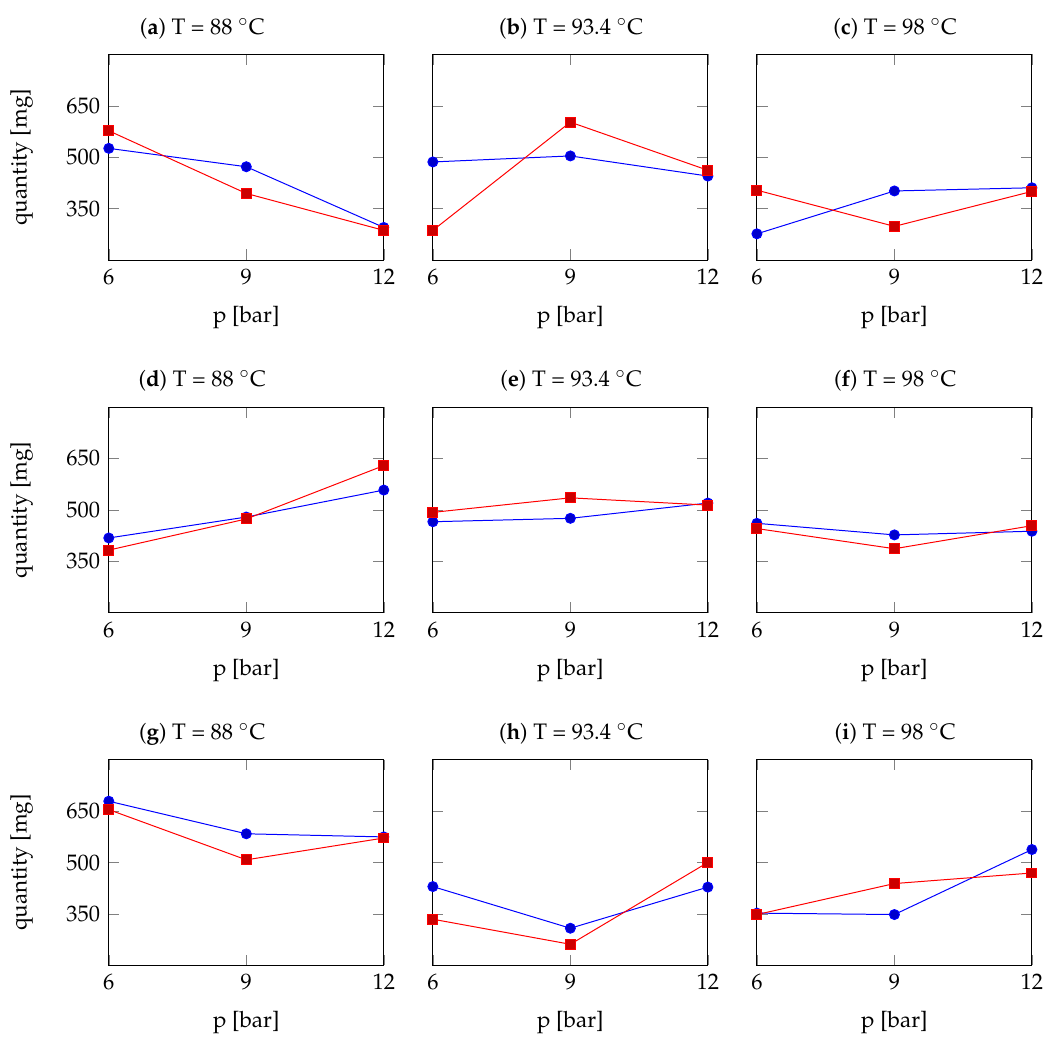
Figure 15. Comparison between the acetic acid extracted through numerical simulations (blue profile with circles) and laboratory measurements (red profile with squares), with different inlet water tempera- tures and pressures and different grain size of Robusta coffee powder. Figures ( a – c ) show the results of optimal granulometry, Figures ( d – f ) of coarse granulometry and Figures ( g – i ) of fine